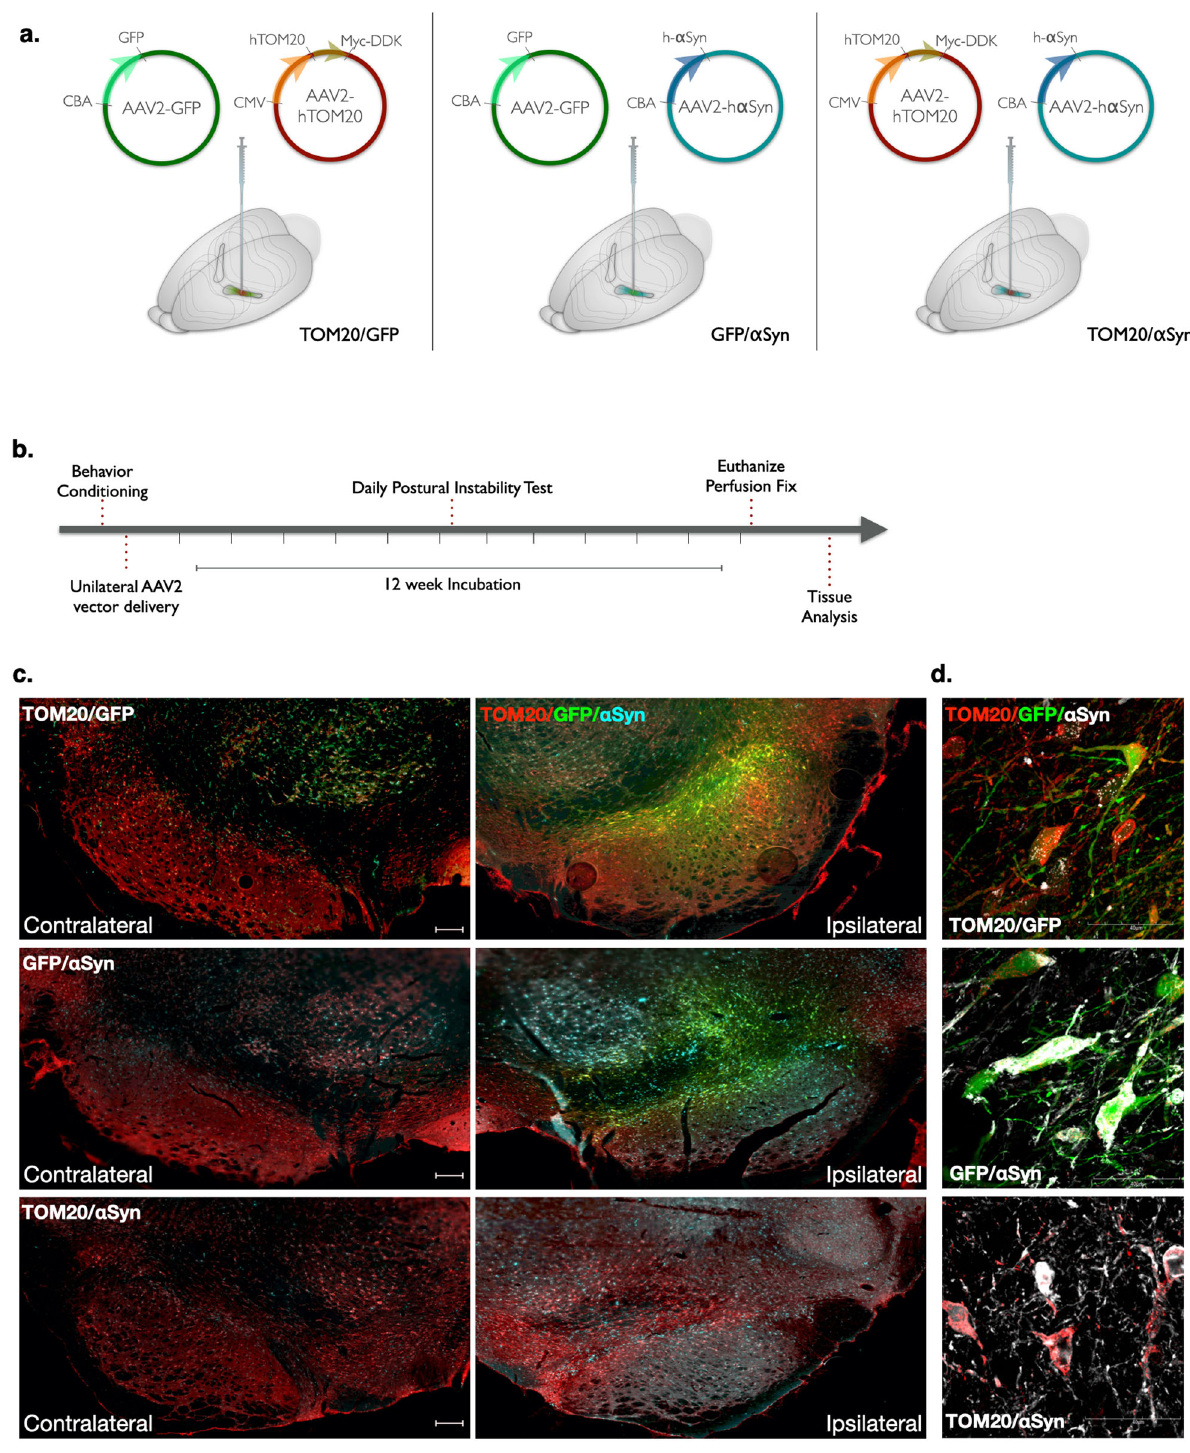
Fig. 1 AAV2-mediated expression of human TOM20 and α Syn in the rat midbrain. AAV2 vectors driving protein overexpression were injected via stereotaxic surgery into the right substantia nigra of adult, male Lewis rats. Vector combinations of AAV2-TOM20/GFP, AAV2- α Syn/GFP, and AAV2-TOM20/ α Syn represent the three treatment groups utilized within this study ( a ). Following vector infusion, animals were monitored daily for motor behavior, and euthanized for tissue collection 12-weeks post-injection ( b ). Representative images from each vector treatment group comparing ipsilateral (injected) and contralateral (non-injected) brain hemispheres; TOM20 (red), α Syn (cyan), GFP (green); scale bar 100 μ m ( c ). Target protein overexpression in neurons 12 weeks following vector expression; TOM20 (red), α Syn (white), GFP (green; d)